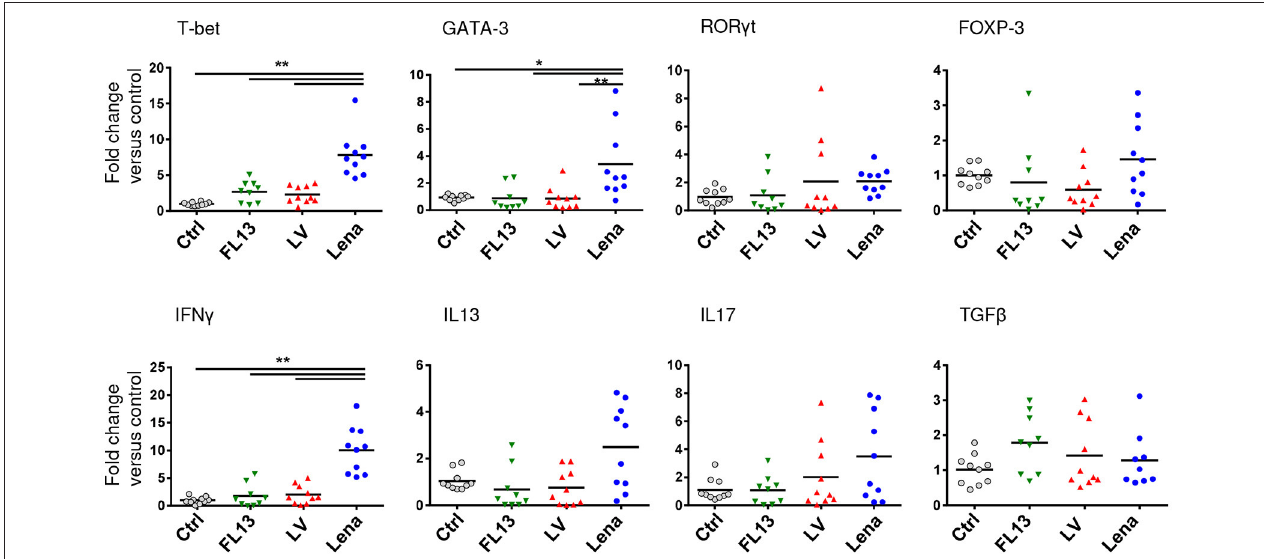
FIGURE 5 | Lena infected MPC trigger a stronger Th1 response than LV and FL13. MPC-enriched PAR were cultured for 24h with FL13 (Green triangle), LV (Red triangle), or Lena (Blue circle) at MOI 0.5 and then co-cultured with allogeneic PBMC at ratio 1:6. After 3 days of co-culture, RNA were extracted and gene expressions were analyzed by RT-qPCR. Four transcriptions factors ( T-bet , GATA3 , ROR γ T, and FOXP3 ) and cytokines ( IFN γ , IL13 , IL17, and TGF β ) expressions were chosen as indicator of respectively Th1, Th2, Th17, and Treg polarization. Data were normalized to the reference gene RPS24 expression and expressed as fold change relative to control. The control samples mean has been calculated for each cytokine, then, each control sample is expressed as a percentage of this mean. Wilcoxon test was performed. * p < 0.05; ** < 0.005.